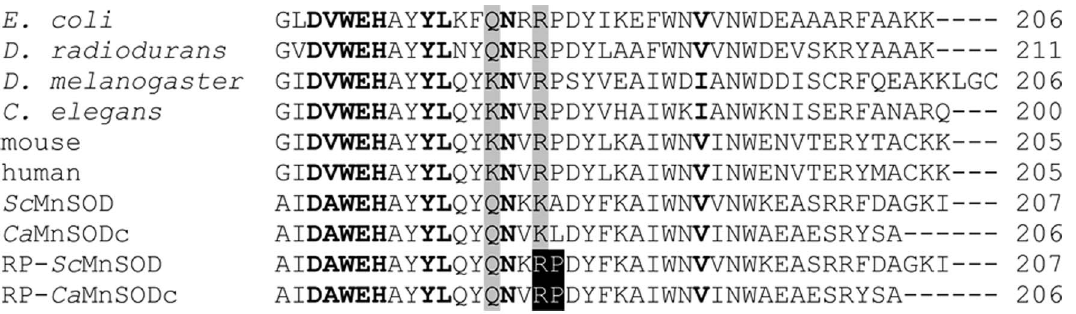
Figure 1. Alignment of MnSOD C-terminal Sequence. Conserved residues and unconserved residues at dimer interface are highlighted in bold and shadowed in gray, respectively. The RP-mutations in Sc MnSOD and Ca MnSODc are highlighted in black.